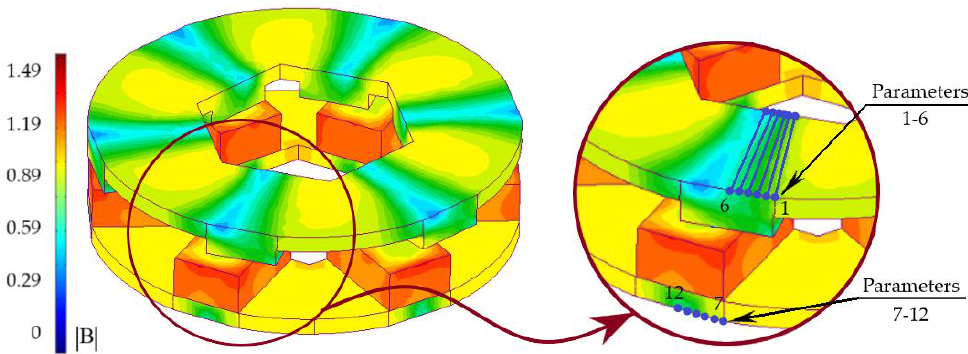
Figure 3. Initial design of the coupling with the distribution of magnetic flux density and illustration of the optimization parameters.